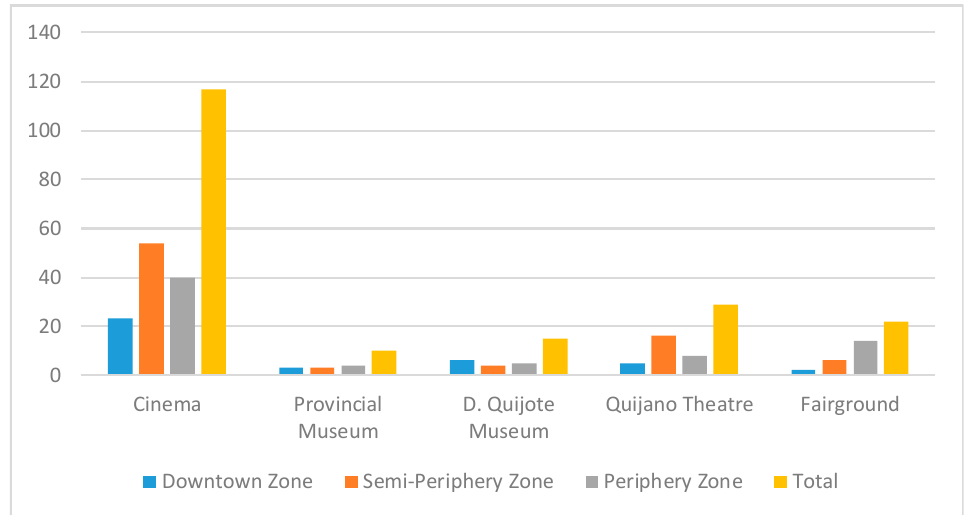
Figure 6. Results of answers related to leisure. Source: Own work.